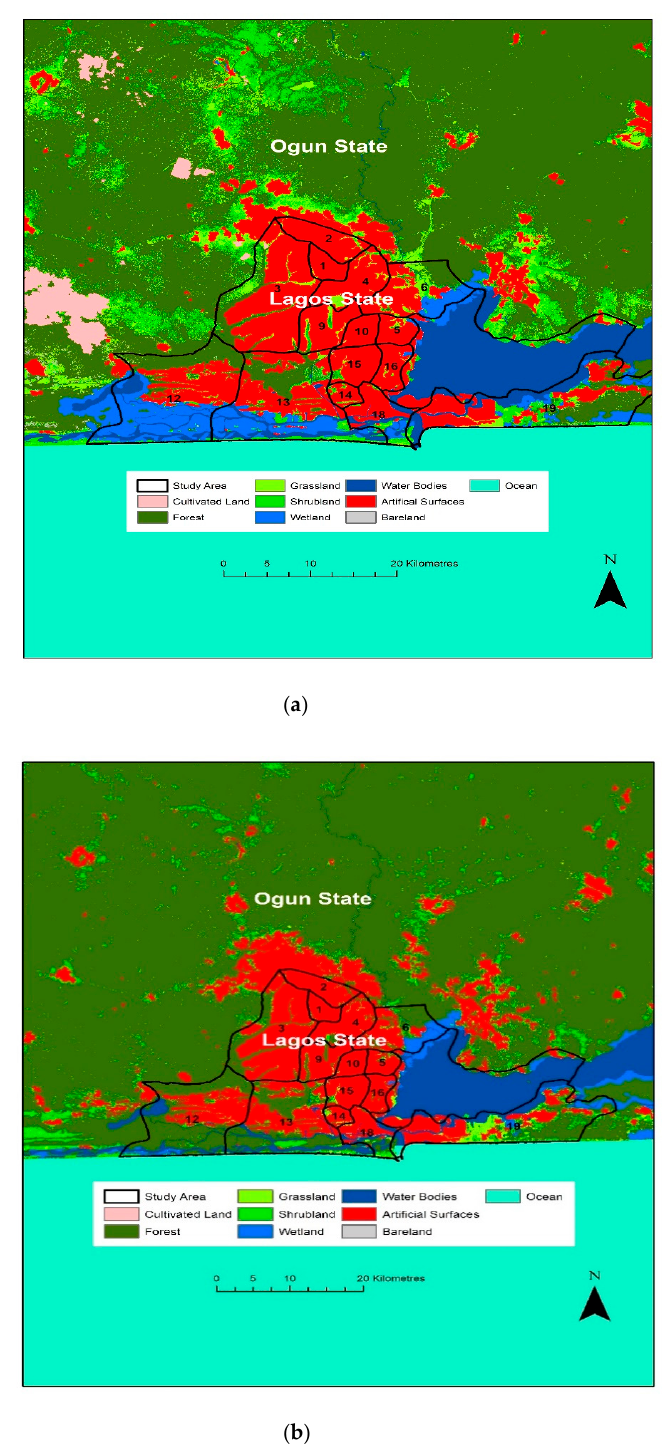
Figure 4. ( a ) Classified map of the year 2000. ( b ) Classified map of the year 2010.